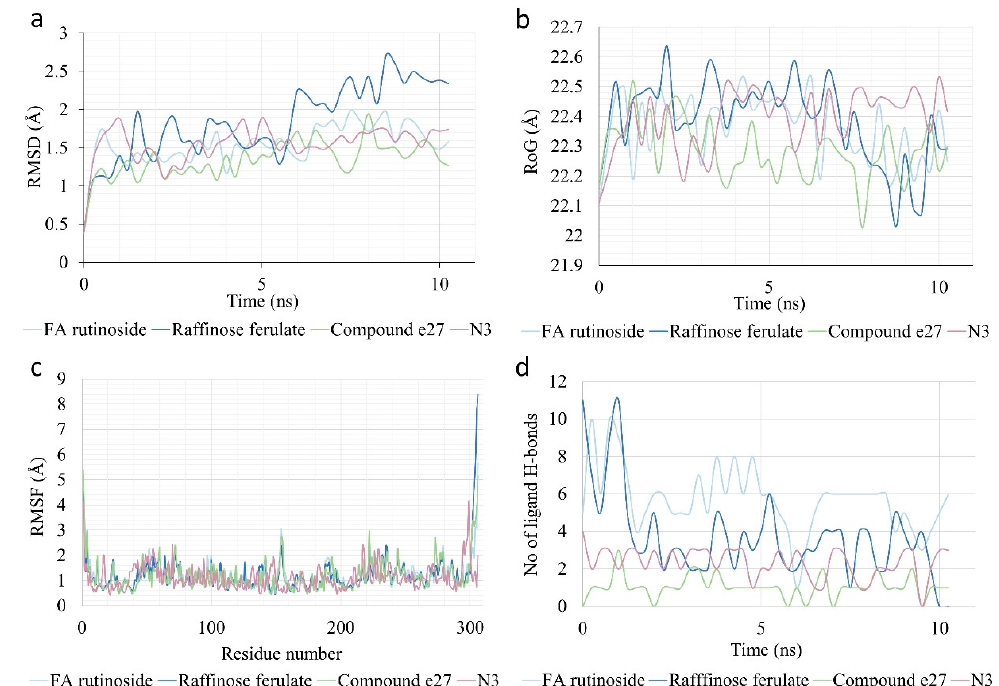
Figure 12. ( a ) RMSD values of the C-alpha atoms of the complexes of the ligands FA rutinoside, raffinose ferulate, compound e27, and reference inhibitor N3 with M pro throughout the simulation time; ( b ) Radius of gyration of the complexes throughout the simulation time; ( c ) RMSF values of residues of M pro in complex with the ligands; ( d ) Number of hydrogen bonds formed between the ligands and M pro throughout the simulation time.